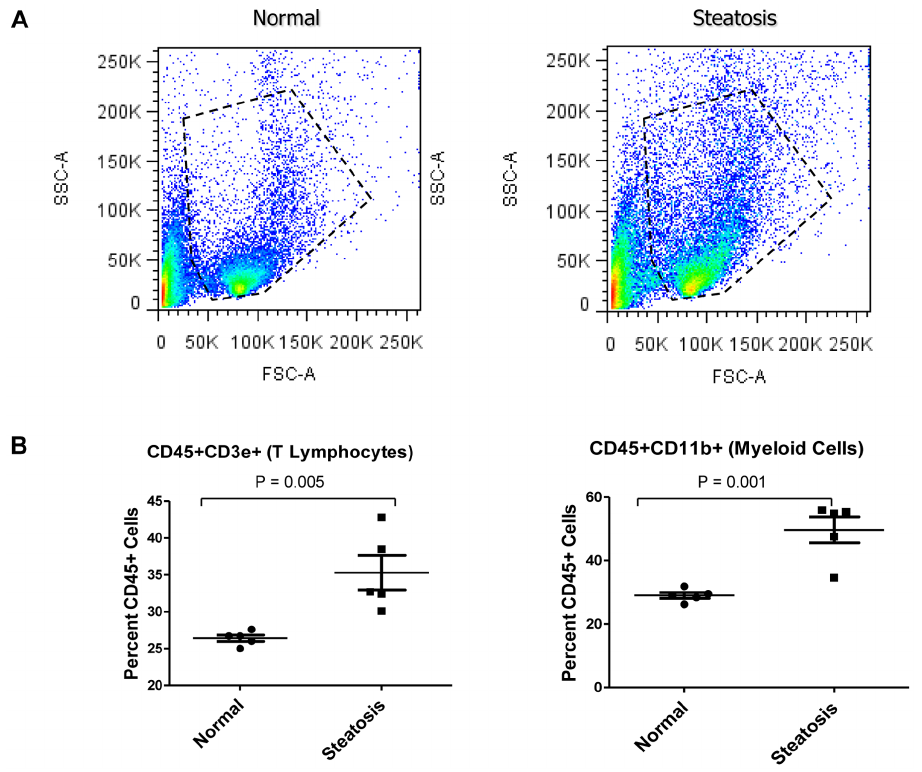
Figure 2. Steatosis results in changes in the inflammatory cell populations in the murine liver. CD45 positive cells were isolated from normal and steatotic digested liver samples by immunomagnetic beads and then stained for the immune markers CD3 and CD11b before being subjected to Flow cytometric analysis. (A) Diagrams are representative scatter plot of flow cytometric analysis for overall CD45 positive cells in the livers. (B) CD45 positive cells were then gated for the percentage of CD3 positive T lymphocytes or CD11b positive myeloid cells. CD3 + and CD11b + subpopulations were both increased in the steatotic livers versus the control livers.